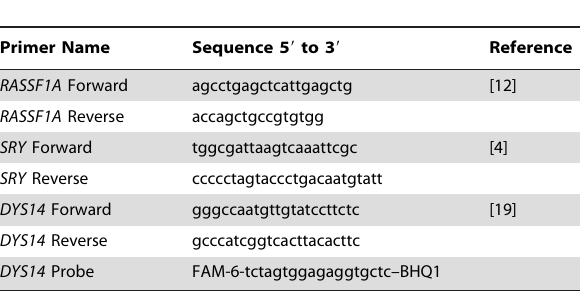
Table 1. Sequences of PCR primers and probes for real time PCR